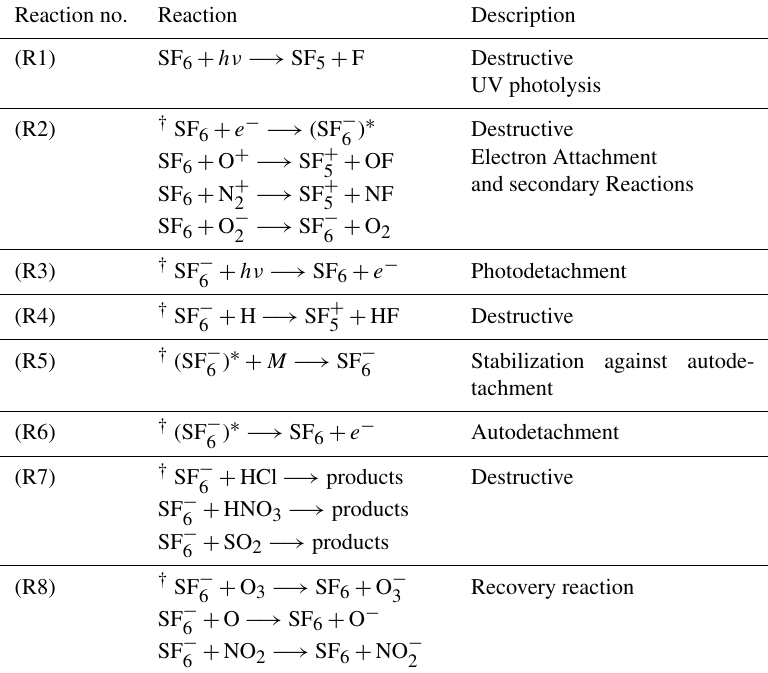
Table 1. Chemical reactions of SF 6 . The labeling of the various reactions mirrors the style used by Reddmann et al. (2001). Reactions labeled with † are included in the SF6